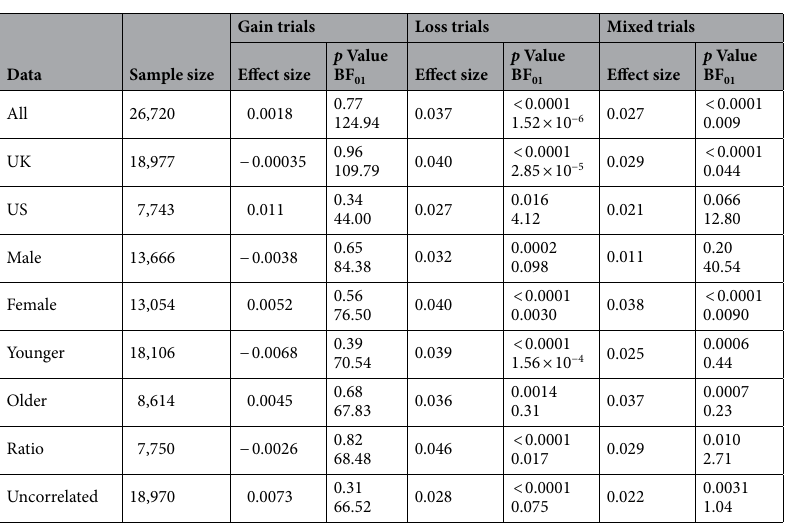
Table 2. Effect sizes for time of day on risk taking for each demographic split. Effect sizes (Pearson’s r) for each demographic and experimental split of the data (country, gender, age, ratio or uncorrelated task designs). Demographic pairs (where total N = 26,720) are every pair of rows after ‘All’. All Bayes Factor tests test for evidence for the null hypothesis (BF 01 ). BF 01 of > 1 indicate support for the null hypothesis. We report the mean, standard deviations and medians for the full sample, and male and female demographic splits in the Supplementary Results (S1). We also report the effect sizes for the proportion of choices with the highest expected value and total points scored for each trial type in the Supplementary Results (S2).